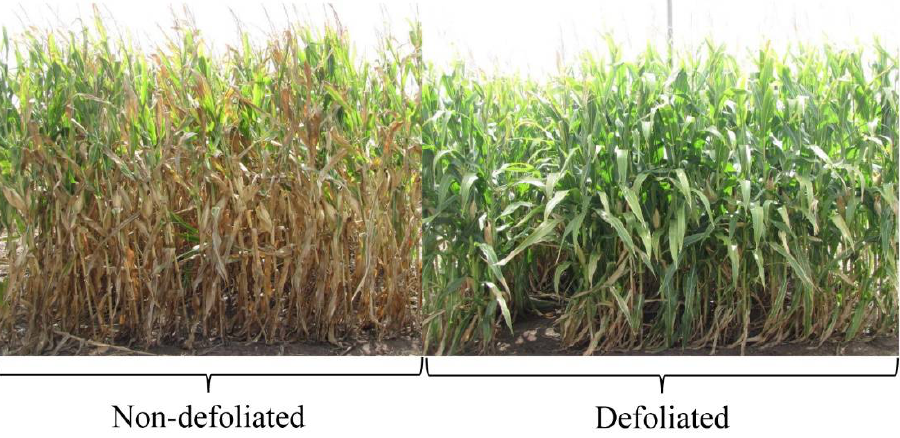
Figure 4. Defoliation dramatically delayed plant senescence under dry conditions. The photo was taken from a trial conducted in Queensland, Australia. The trial was irrigated weekly with about 40 mm of water until tasselling. It was noted that the color of cobs on the defoliated plants indicated that they reached physiological maturity while the plants were still green.